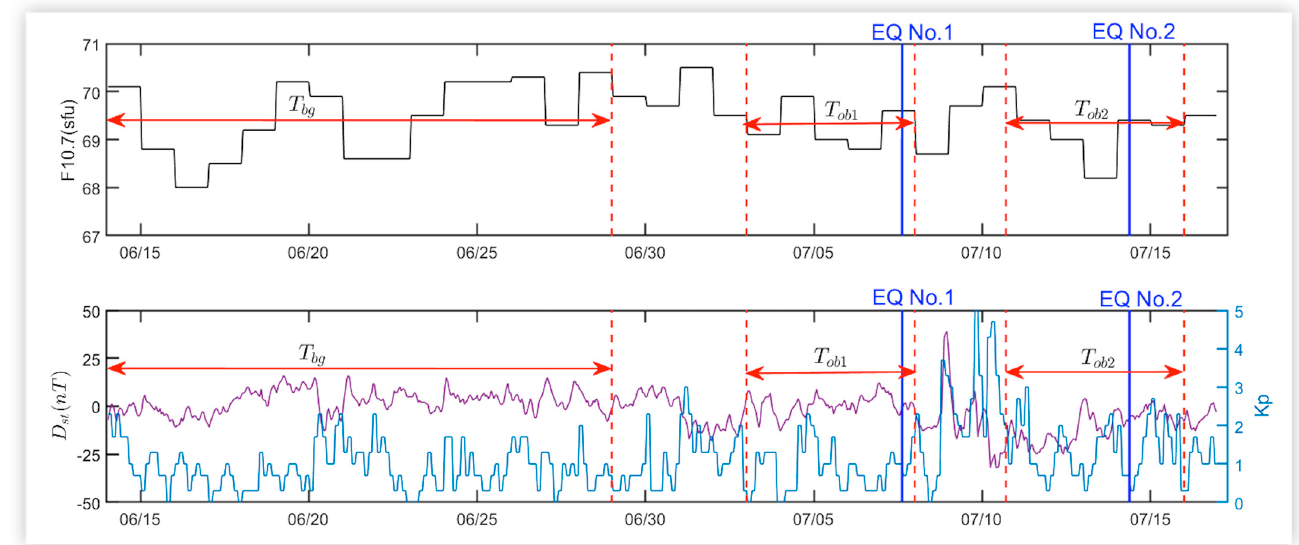
Figure 1. The levels of indexes F10.7, Dst and Kp. T bg is the time interval of the background data, and T ob 1 and T ob 2 are the observed intervals for case No. 1 and No. 2, respectively. The blue vertical lines illustrate the time of the main shocks.